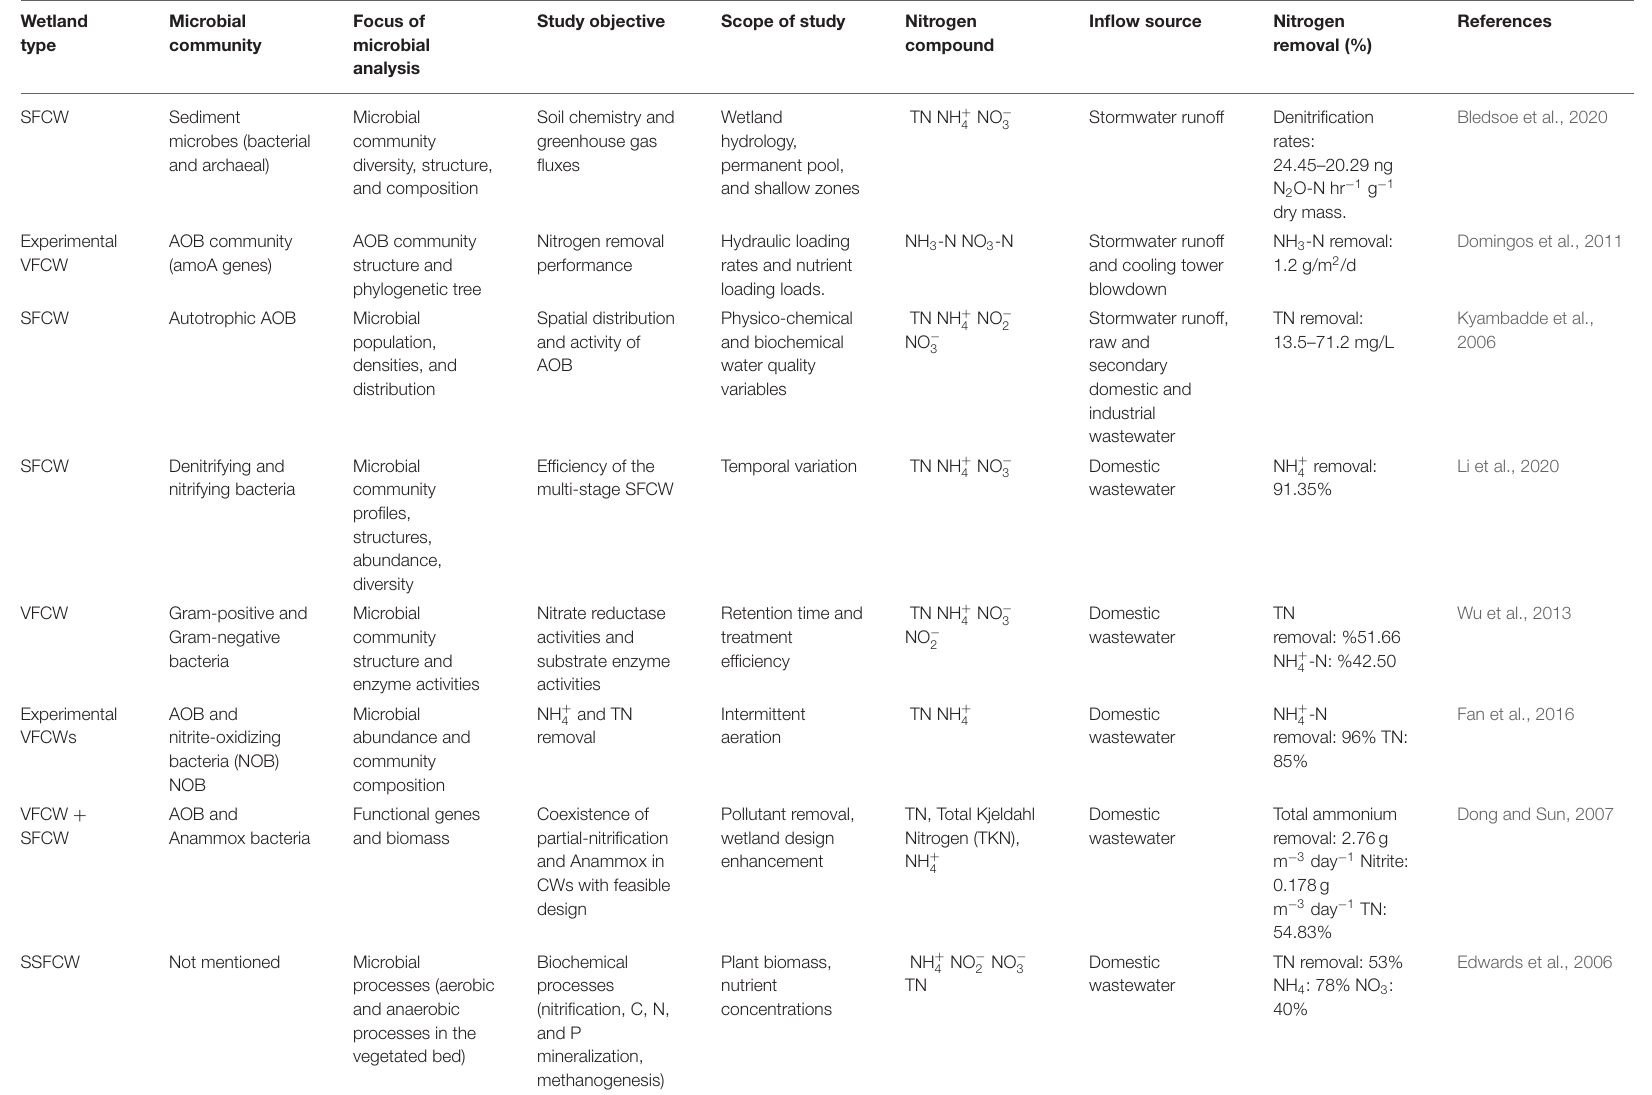
TABLE 1 | Summary of studies investigating microbial communities responsible for N transformation in different types of CWs. Wetland